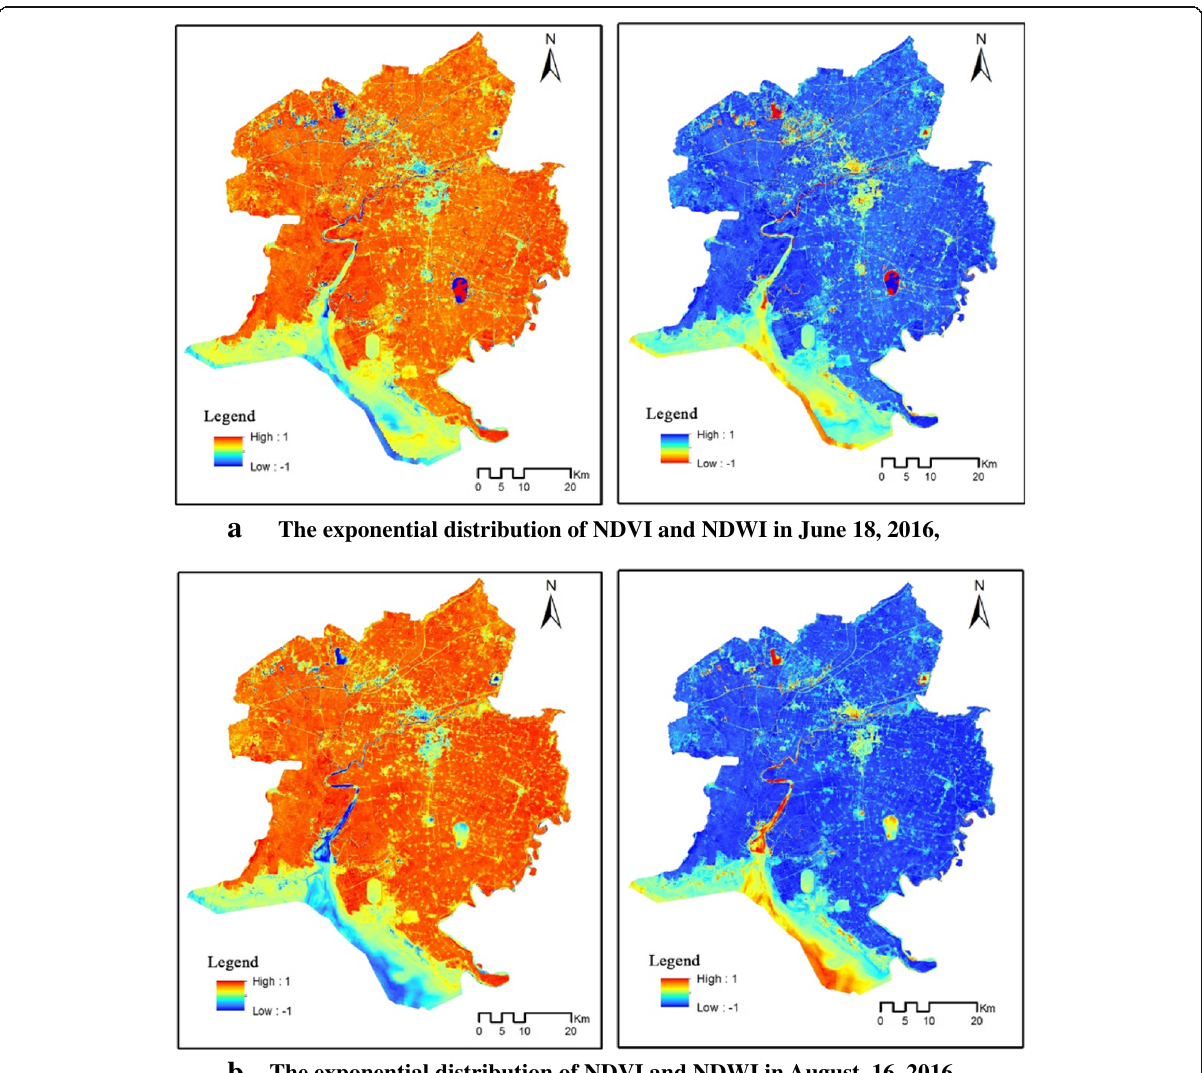
Fig. 6 a The exponential distribution of NDVI and NDWI in 18 June 2016, b The exponential distribution of NDVI and NDWI in 16 August